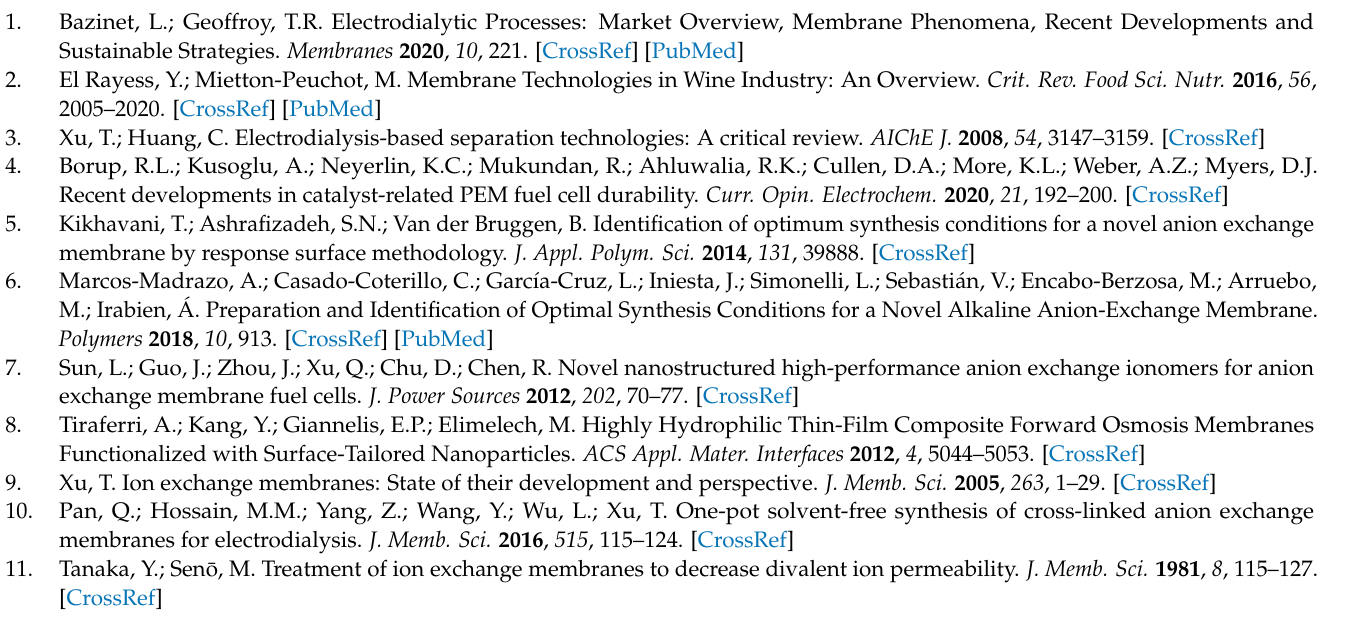
This capacitance includes the capacitances of the electric double layers (EDL) on the membrane-solution boundaries, as well as the capacity caused by the asymmetry of the depleted and enriched DBLs, which occurs when a direct electric current flows. The capacity of the EDL is dominant in the given (10 3 –10 5 Hz) frequency range